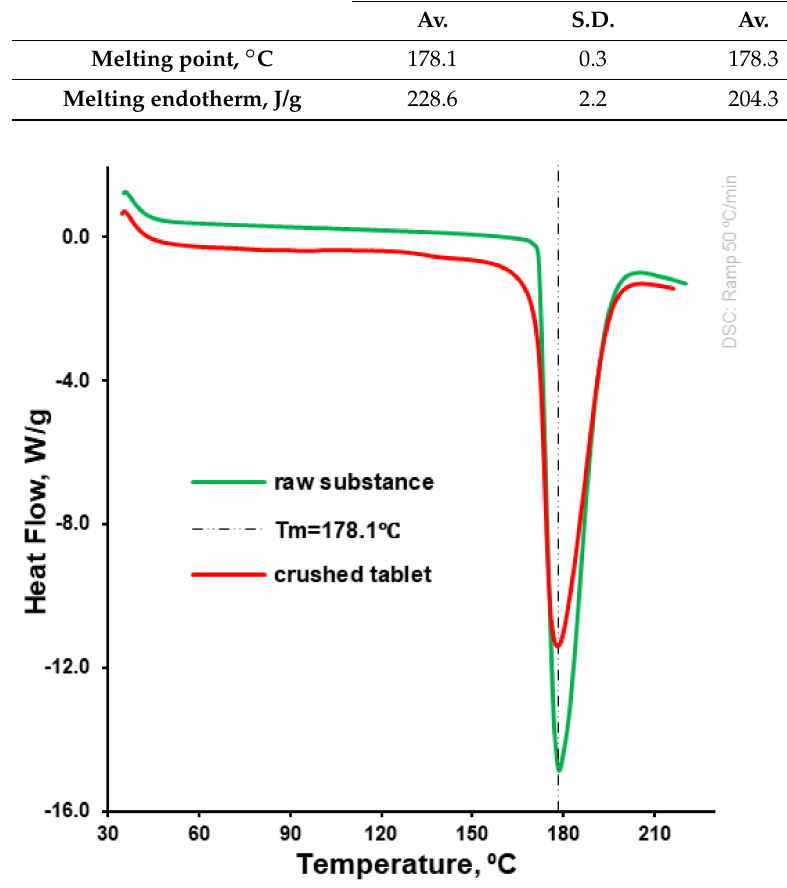
Figure 6. DSC profile of raw isoniazid and crushed